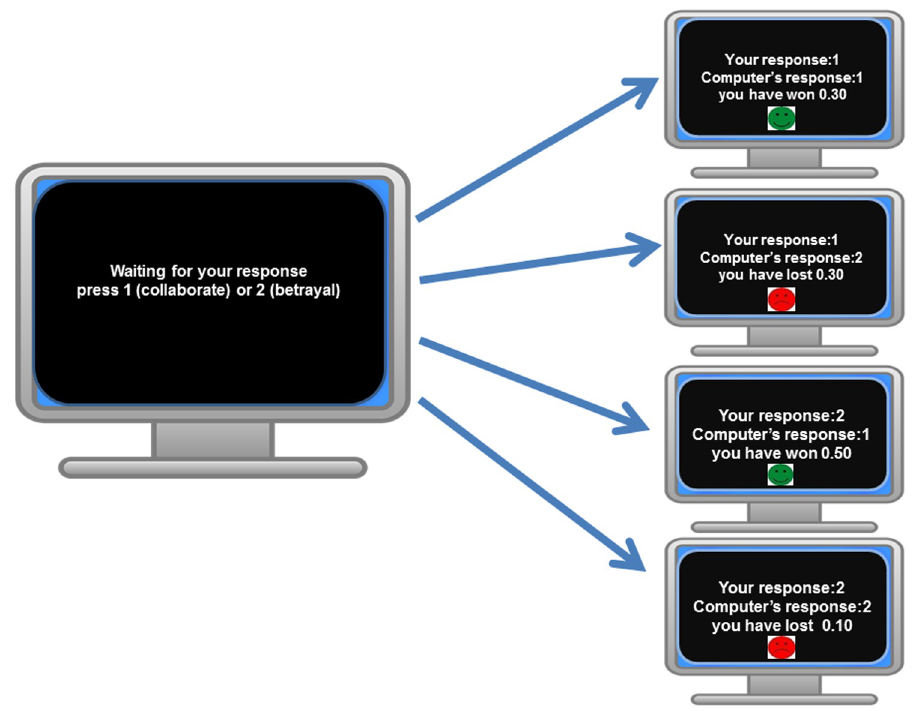
Fig 2. Choice and feedback screen. Participants were presented with two options and the choice screen remained until both participants made a response (pressing keys 1 or 2). Right side: Depending on the responses of both participants one of four potential feedback screens were presented (2 seconds). In the positive & negative environmental context there was a 30 percent chance of a screen informing subjects of a further random gain/loss, before the beginning of the next